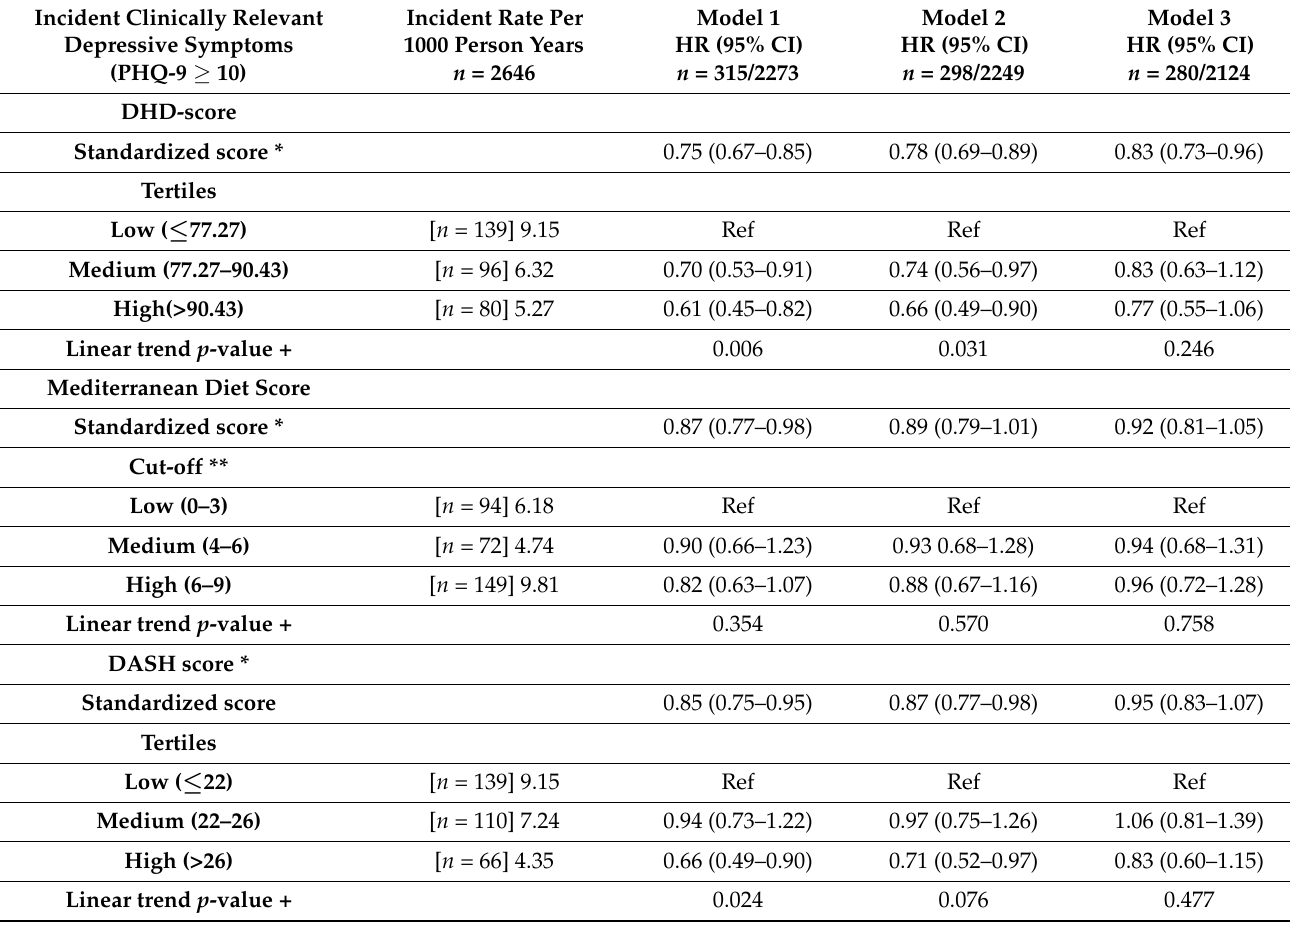
Table 2. Longitudinal association of dietary patterns with incident clinically relevant depressive symptoms during 7-years of follow-up (median 6.1